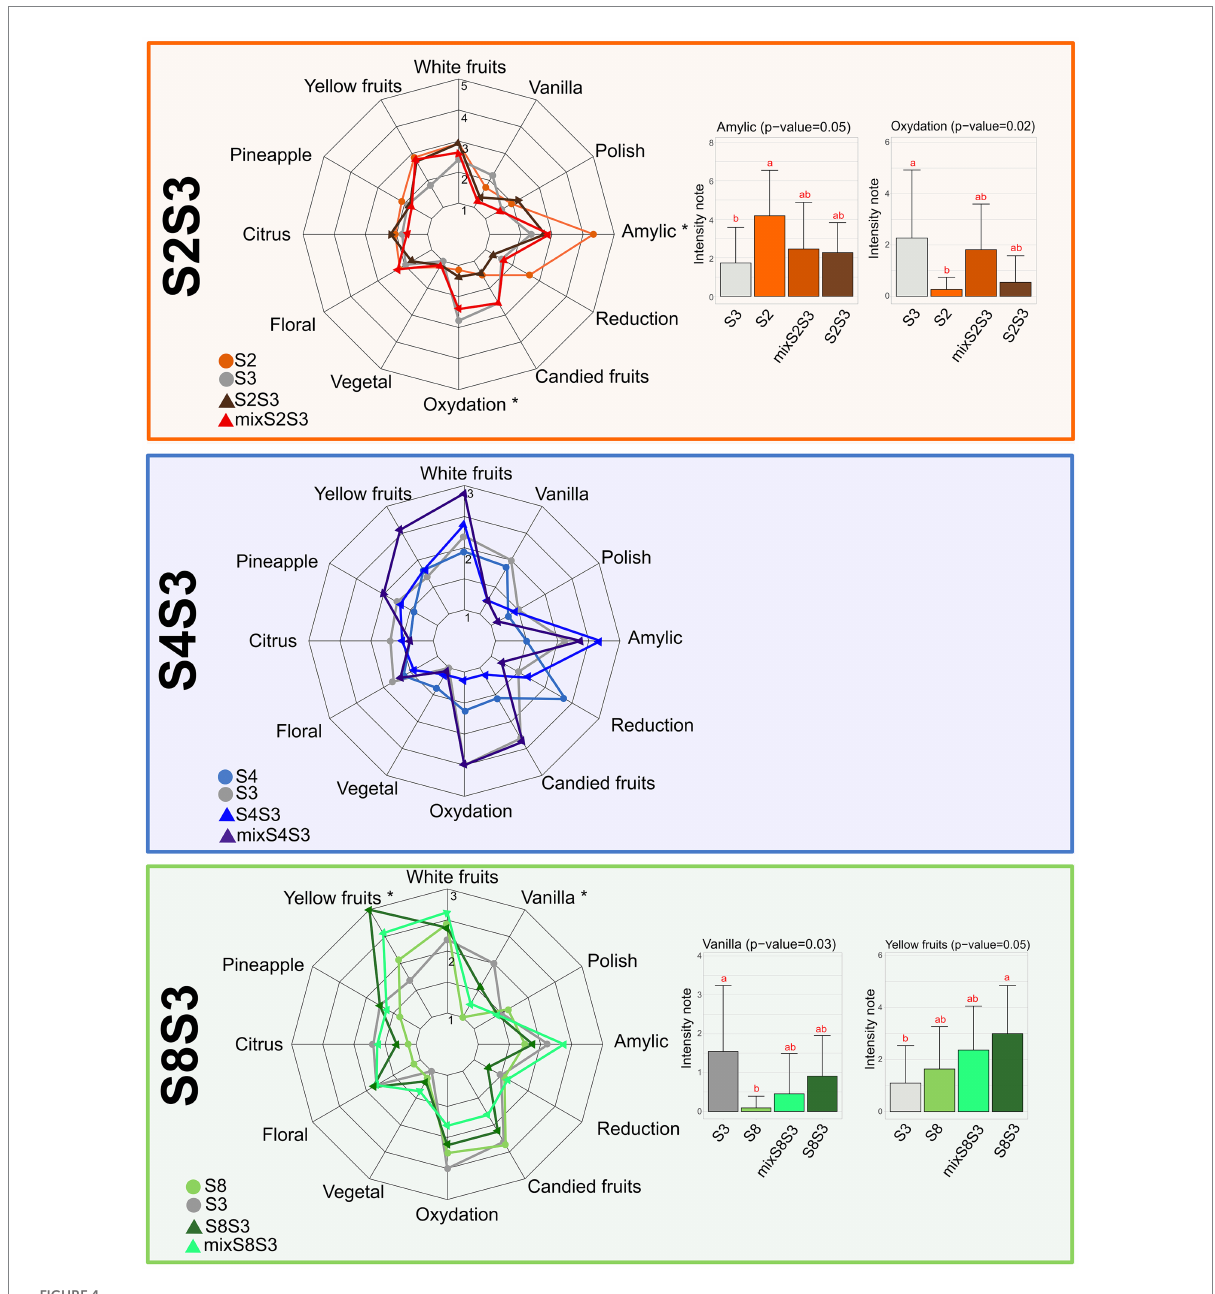
FIGURE 4 Impact of cocultures on Chardonnay wine sensory profile. Sensory profiles of Chardonnay wines from pure cultures, corresponding cocultures and post-alcoholic fermentation mixes for each modality S2S3 (orange), S4S3 (blue) and S8S3 (green) Histogram of score intensity for attributes showing significant differences (Newman Keuls test, value of p ≤ 0.05) between the four wines studied by modality. For modality S4S3 no attribute was significantly different between the different